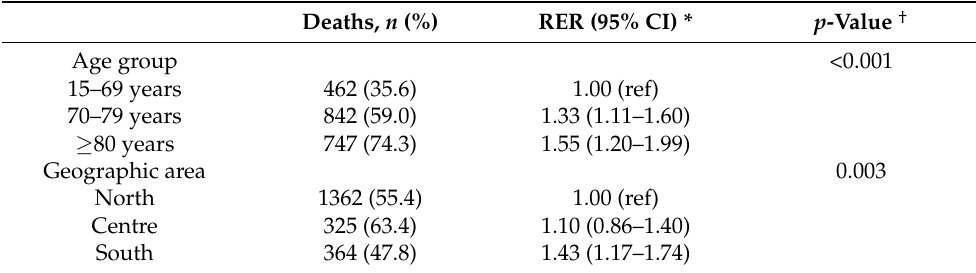
Table 8. Multivariate relative excess risk (RER) of death from vulvar squamous cell carcinoma